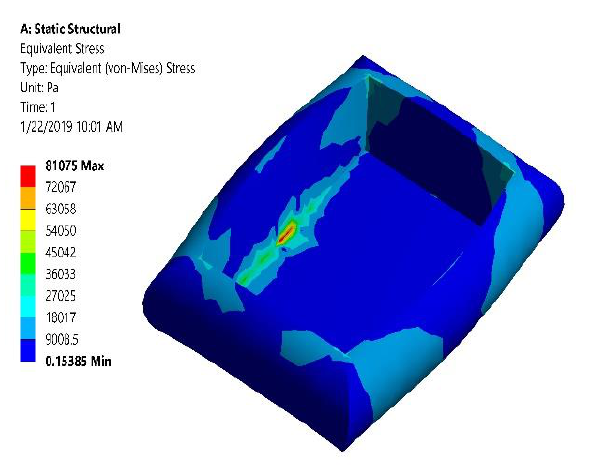
Figure 12. Stress contour of skirt